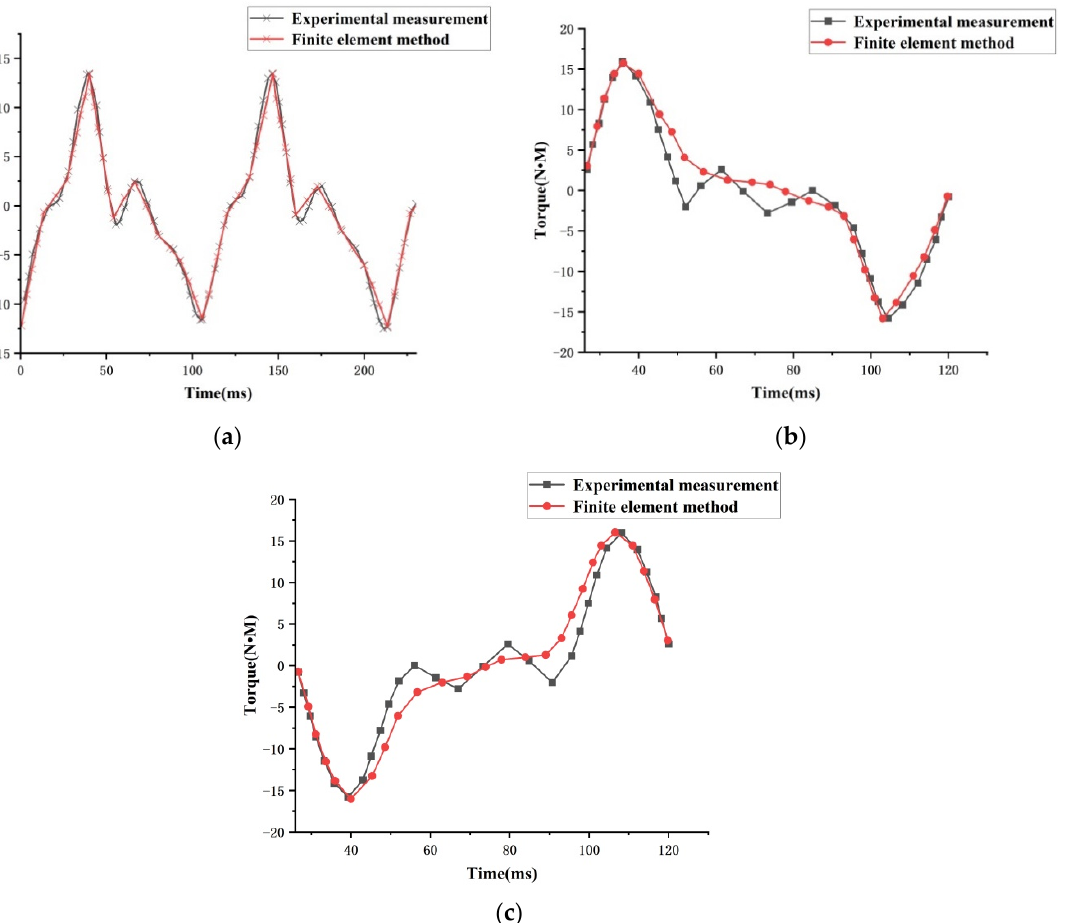
Figure 17. Mixed torque test results: ( a ) forward torque; ( b ) x -axis torque; and ( c ) y -axis torque.